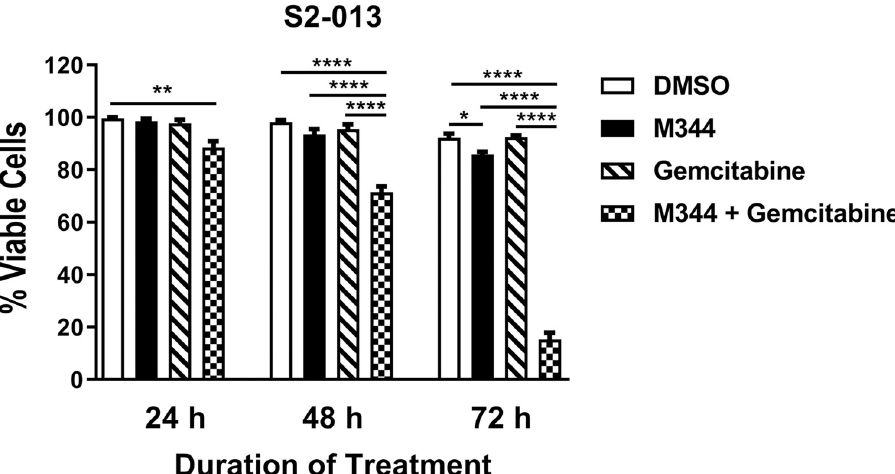
Fig 12. M344 impairs viability in combination with gemcitabine. S2-013 pancreatic cancer cells were treated with 0.1% DMSO, 10 μ M M344, 100 nM gemcitabine, or 10 μ M M344 + 100 nM gemcitabine. Viability was assessed by the trypan blue exclusion assay at 24, 48, and 72 hours and graphed as the number of live cells/total cells x 100. Each error bar represents the standard error of the mean. The results from 0.1% DMSO control treatment versus treatment with each M344 concentration were compared using Ordinary One-way ANOVA with Dunnett’s Multiple Comparisons test in GraphPad Prism Version 8.4.2. The asterisks indicate the p values: � p < 0.05, �� p < 0.01, ���� p < 0.0001.